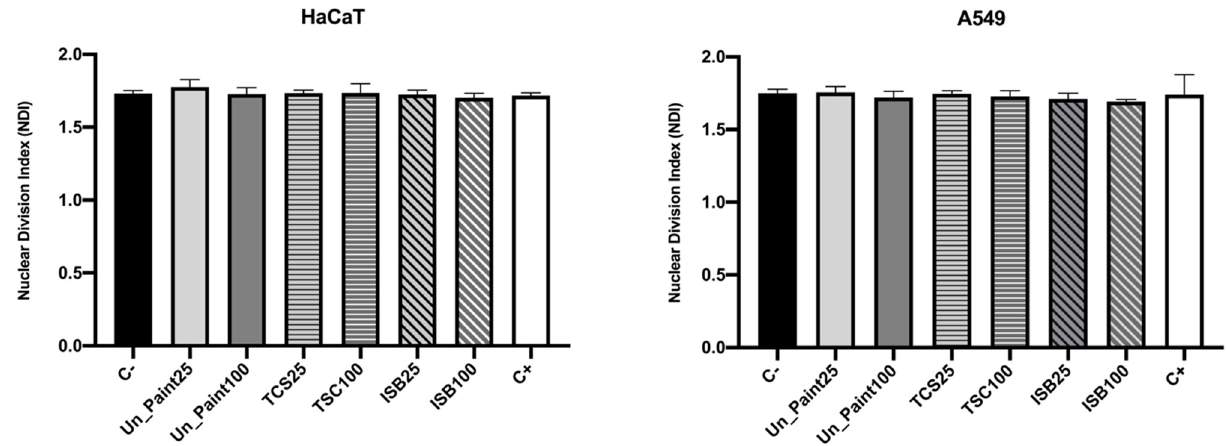
Figure 7. Nuclear division index (NDI) of HaCaT ( left ) and A549 ( right ) cell lines, after exposure to extracts of the samples (in the x axis) Un_Paint, TCS or ISB extracts for 24 h. C- negative control (complete medium), C+ positive control (MMS 800 µM solution). The values are expressed as mean ± standard deviation. The statistical significance of samples compared to C- is represented by * (One-way ANOVA; p < 0.05). The statistical significance of samples compared to Un_Paint is represented by # (Two-way ANOVA; p < 0.05). The statistical significance of the extract on A549 cells compared to the same extract, in the same concentration, on HaCaT cells is represented by & (Two-way ANOVA; p < 0.05).